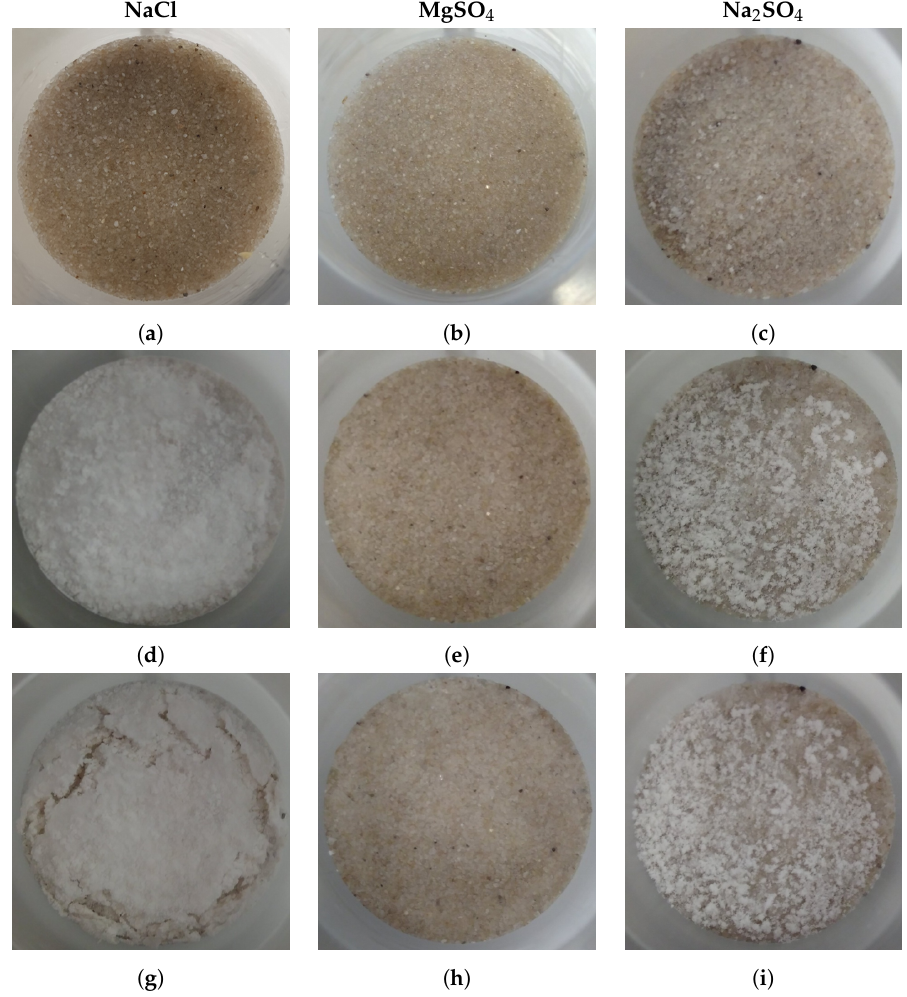
Figure 3. Photos of sample surface for selected samples directly after preparation, two days of evaporation, and before crust separation for samples with NaCl solution ( a , d , g ), MgSO 4 solution ( b , e , h ), and Na 2 SO 4 solution ( c , f , i